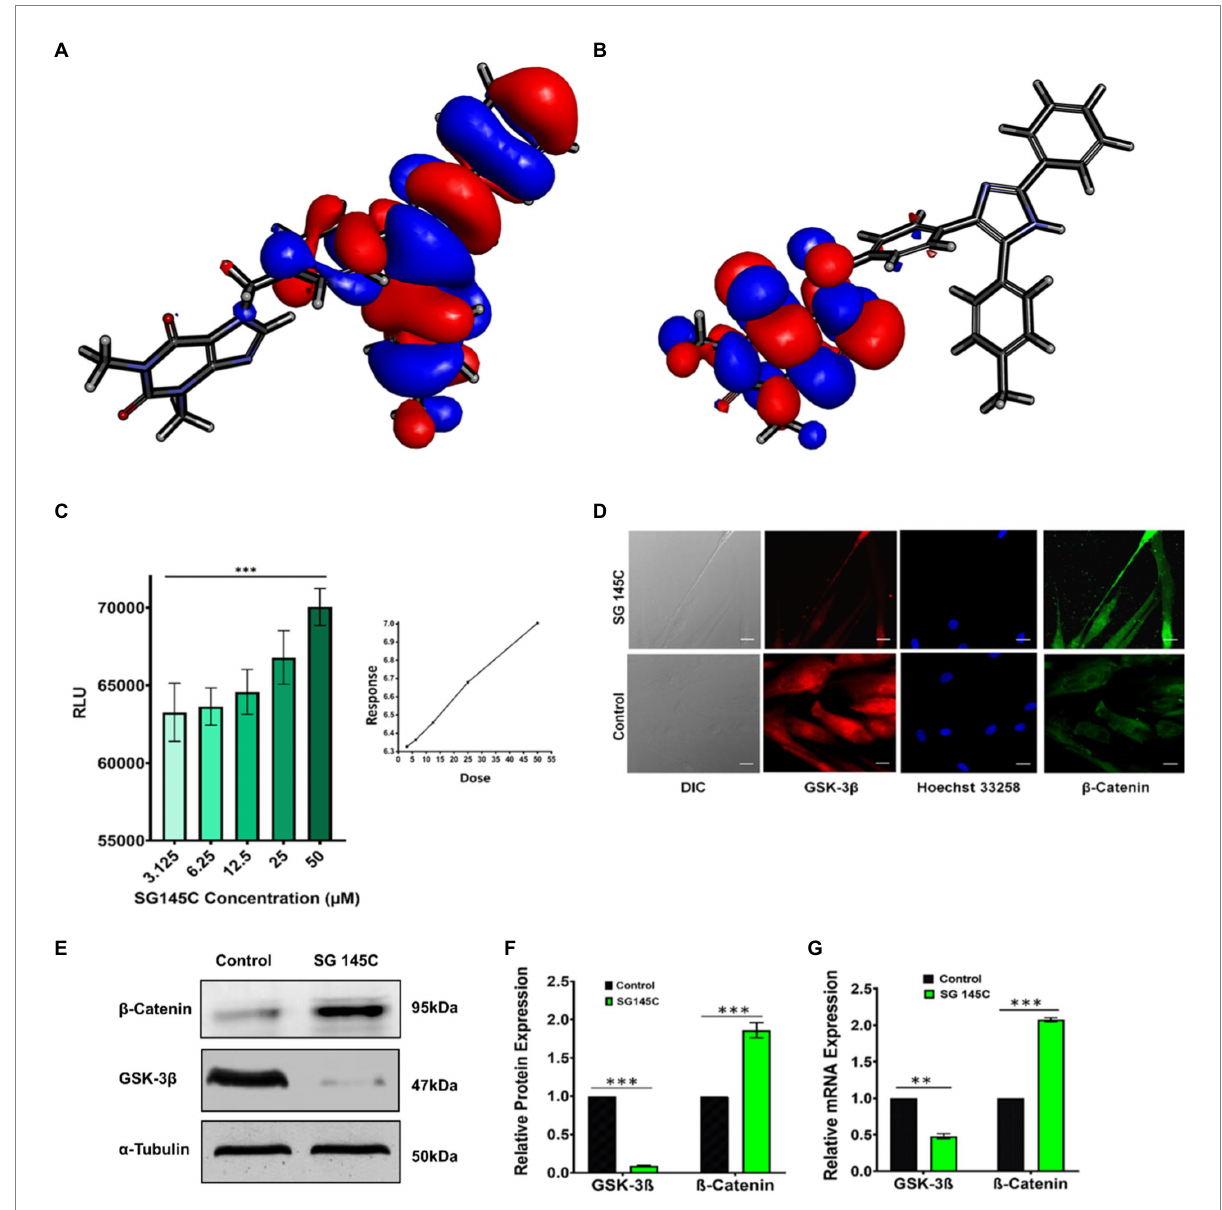
FIGURE 6 GSK-3 β Inhibition by SG-145C results in increased β -Catenin levels. (A,B) HOMO-LUMO isosurface showing localization of orbitals. (C) Kinase-Glo luminescent assay to check the inhibition of GSK-3 β revealed a direct dose-dependent inhibition. (D) Immunocytochemistry assay reveals the expression of GSK-3 β (AF-488) and β -Catenin (AF-647) in differentiated neurons. Images were captured in 40× magnification where the scale bar corresponds to 20 μ m. (E,F) Immunoblot and densitometric analysis and (G) qPCR to check the expression of two key regulators of Wnt Pathway, GSK-3 β , and β -Catenin in response to SG-145C treatment. n = 3 for all sets of experiments and significance was calculated using student’s unpaired t -test. * p < 0.05; ** p < 0.01; *** p <